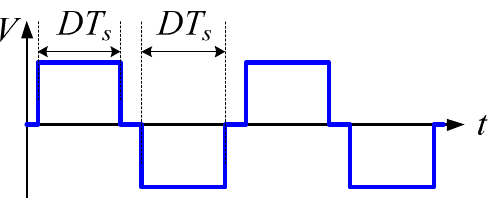
Figure 2. Voltage waveforms synthesized by phase-shifted full-bridge converter according to the switching duty cycle D .